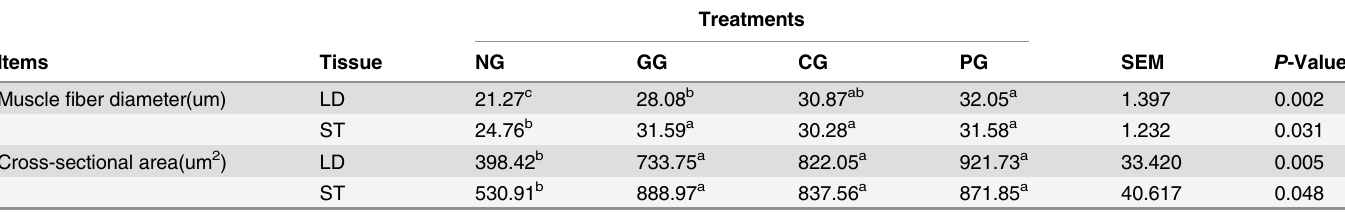
Table 6. The effects of GHRP-2 and CS on the myofiber parameters in yaks with growth retardation.